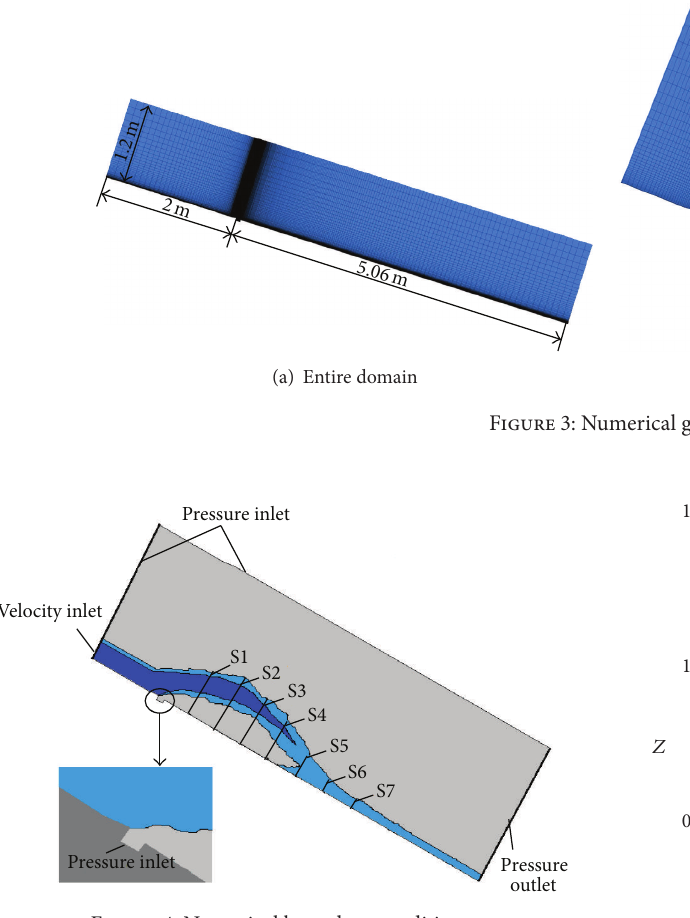
Figure 4: Numerical boundary conditions.